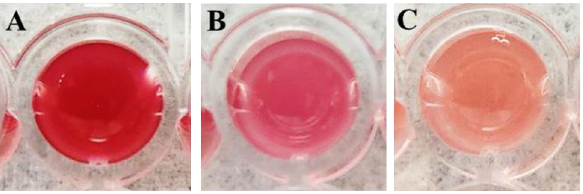
Figure 2. Red-pigmented cultures with various concentrations of quercetin. Dose response showing inhibitory effects of quercetin on prodigiosin production in S. marcescens ( A ) Control, ( B ) treated with ¼ MIC, ( C ) with ½ MIC. Intracellular prodigiosin was extracted and quantified. The results were reproduced in three experiments, and the error bars indicate standard deviations.